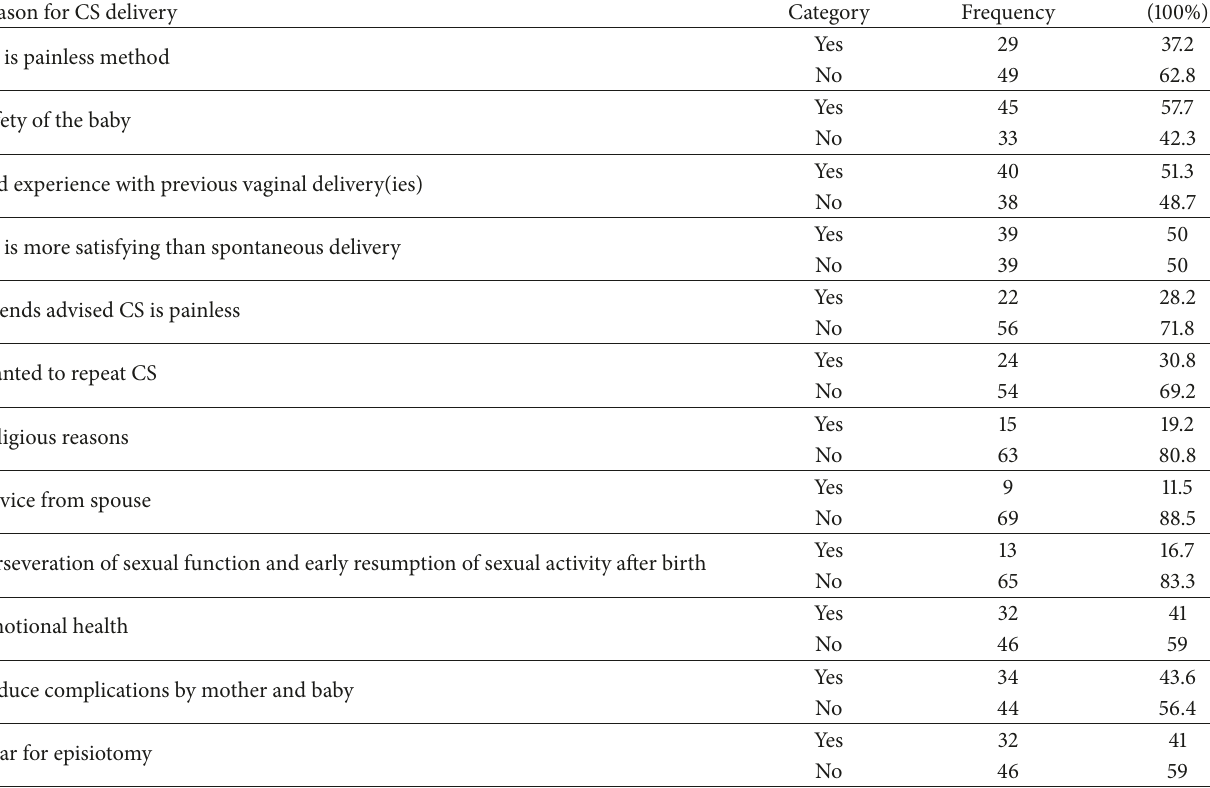
Table 2: Factors Influencing the Choice for CS Birth.